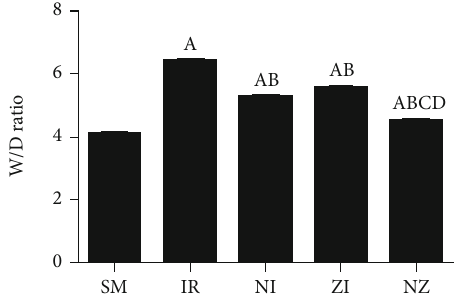
Figure 3: Water content in the lung tissue. The rats were randomly divided into fi ve groups. Brie fl y, the rats in the SM group received sham operation, while the left lung hilum was subjected to 1 h of ischemia followed by reperfusion up to 3h in the IR group. Intraperitoneal Nec-1 (1 mg/kg) and z-VAD-fmk (3 mg/kg) were administrated before lung ischemia in NI and ZI groups, respectively, and combined administration of Nec-1 and z-VAD- fmk was given in the NZ group. After 3 h of reperfusion, lung edema was assessed by the W/D ratio, W/D ratio, and wet/dry weight ratio. Data were presented as mean ± SD , n = 8 in each group. a P < 0 : 05 compared with the SM group, b P < 0 : 05 compared with the IR group, c P < 0 : 05 compared with NI and ZI